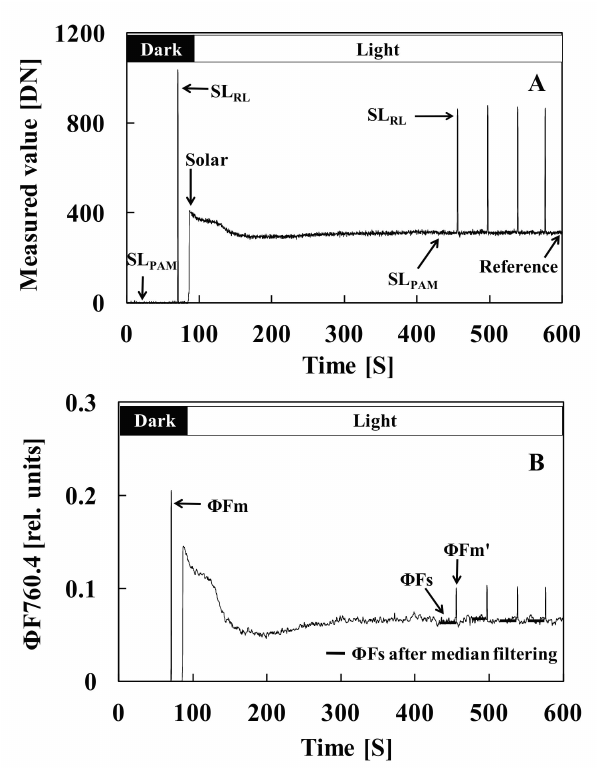
Figure 2. Typical measurement diagrams of ChlF parameters using PAM and FLD-LISP. ( A ) a time sequence of lighting for leaf radiance spectral measurements using a HR2000+ spectrometer and PAM measurement during the dark and solar light adaptation periods. SL RL is the saturation light pulse (PPFD, Photosynthetic Photon Flux Density): 6000 µ mol m − 2 s − 1 ) using a red laser (660 nm) for measurement using HR2000+ and SL PAM is the saturation light pulse (blue LED, PPFD about 10,000 µ mol m − 2 s − 1 ) for measurement using JUNIOR PAM (Heinz Walz GmbH, Effeltrich. Germany); ( B ) temporal changes in ChlF yield ( Φ F: near 760.4 nm) estimated by FLD-LISP, where Φ Fm and Φ Fm’ are the laser saturation pulse-induced ChlF yields in dark-adapted and light-adapted leaves, respectively. The thick line is the mean value after median filtering during 10 s before the SL RL illumination for estimating the steady-state ChlF yield ( Φ